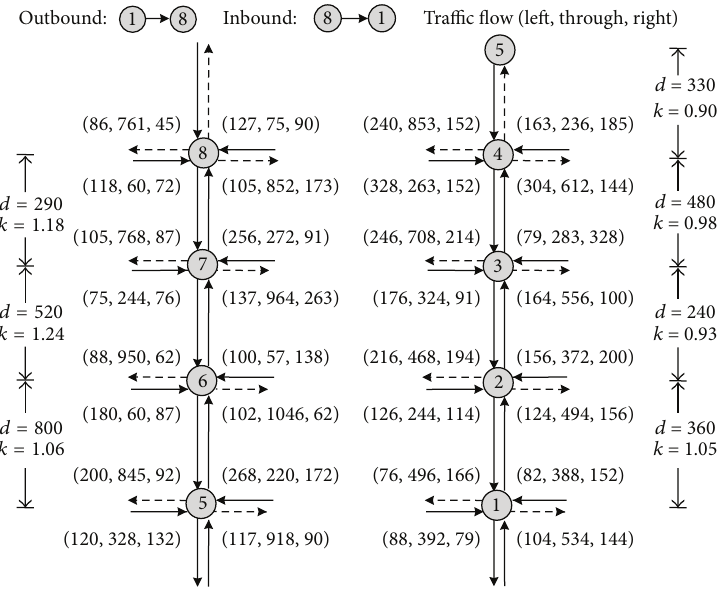
Figure 3: Data of the case study.